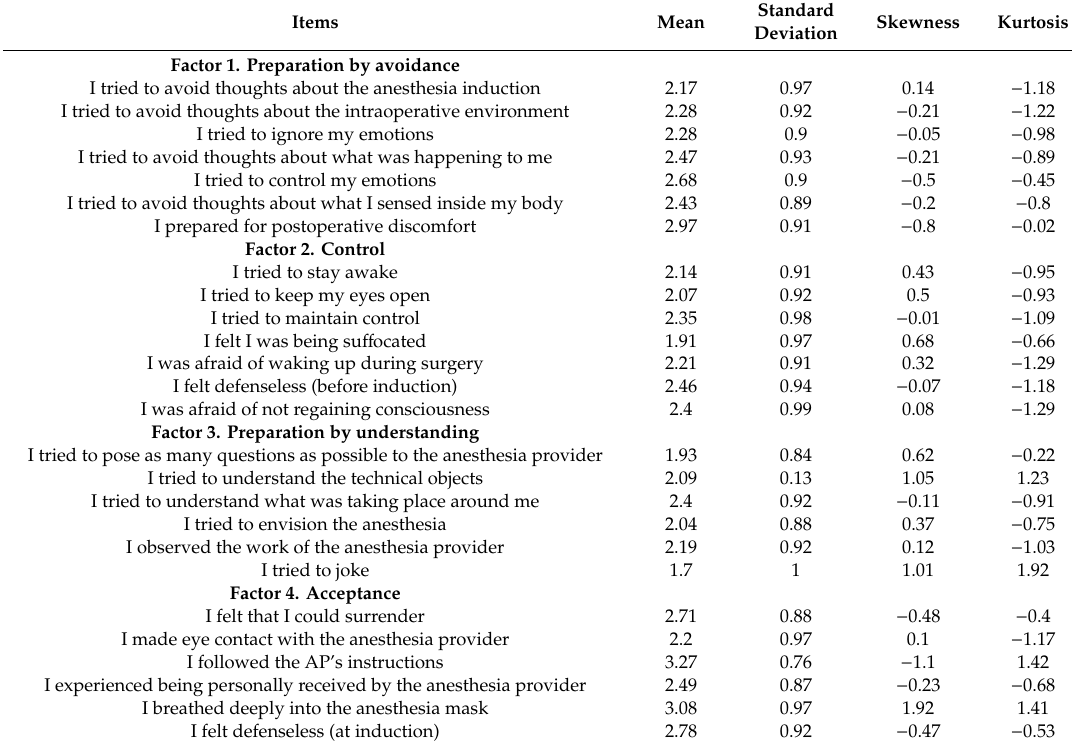
Table 1. The item analysis (N =